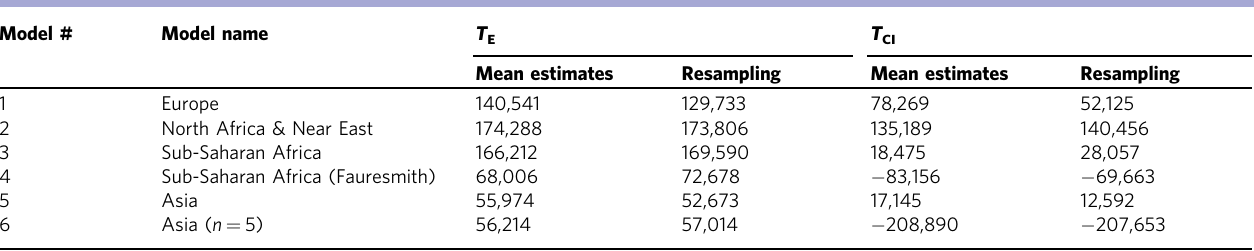
Additional models were run for Sub-Saharan Africa and Asia. Included here are data derived from models using mean estimate and resampling procedure. T E is the estimated extinction date in years before present. T CI is the upper bound of the 95% con fi dence